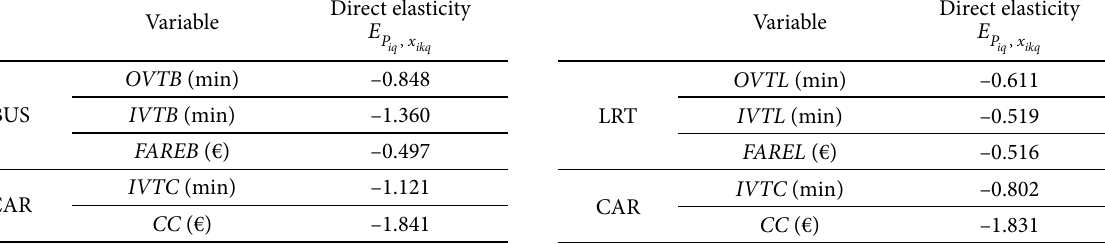
Table 10. Direct elasticities of LRT vs. Car Direct Variable